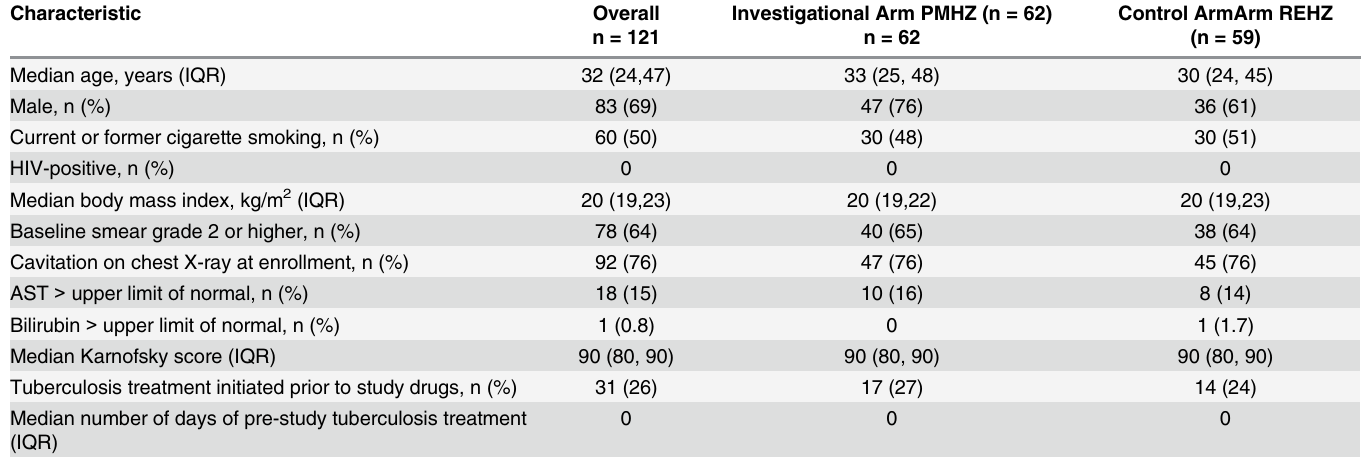
Table 1. Baseline characteristics of participants in the intention-to-treat analysis population. Abbreviations: AST, aspartate aminotransferase; IQR, inter-quartile range.